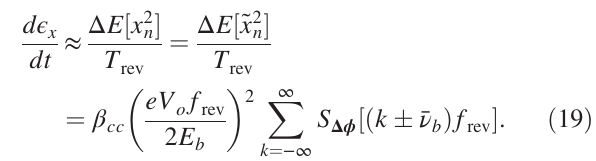
FIG. 3. Growth rate dependence on bunch length C Δ ϕ ð σ ϕ Þ , phase noise. The LHC nominal bunch length is shown for